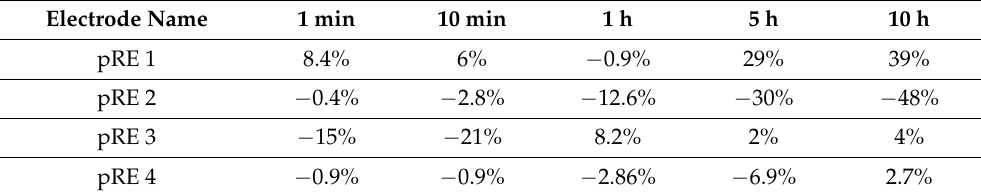
Figure 3. OCP measurements of four different electrodes against an electrochemical Ag/AgCl RE. pRE 4 exhibits the lowest drift, while the other electrodes exhibit an unstable OCP, especially within the first hour. Table 2. OCP changes at different points of the long-term recording shown in Figure 3.